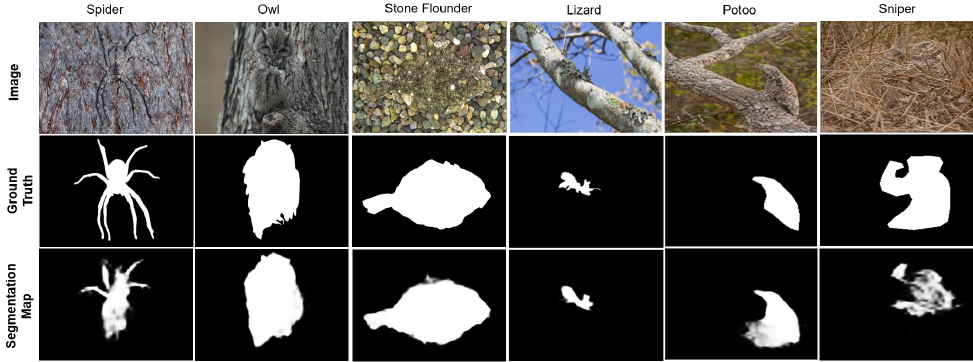
Figure 7. Generalization verification results of the proposed PRNet (Best viewed in